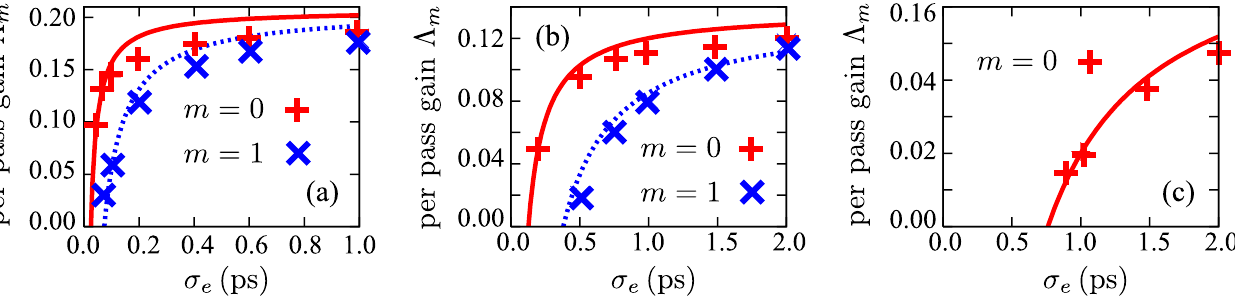
FIG. 4. (Color) Supermode gain rates for the 5-keV (a), 12-keV (b), and 20-keV (c) radiation cases detailed in Table I, using a per-pass cavity loss (cid:1) ¼ 0 : 15 . Simulation points were determined by decomposing the longitudinal radiation onto the Gauss-Hermite modes and are plotted for the lowest two order modes when they could be determined (and are nonzero). Theory is given by the lines, where ffiffiffi p (cid:4) ½ð g (cid:3) (cid:1) Þ (cid:3) (cid:2) 2 ð 2 m þ 1 Þ =(cid:2) (cid:5) , and we have replaced g ! ð 1 (cid:3) (cid:1) Þ g so that (cid:3) ‘ 2 = 2 (cid:3) g (cid:2) the power growth rate (cid:3) m e ! ! the infinite pulse per-pass gain of ½ð 1 þ g Þð 1 (cid:3) (cid:1) Þ (cid:3) 1 (cid:5) .